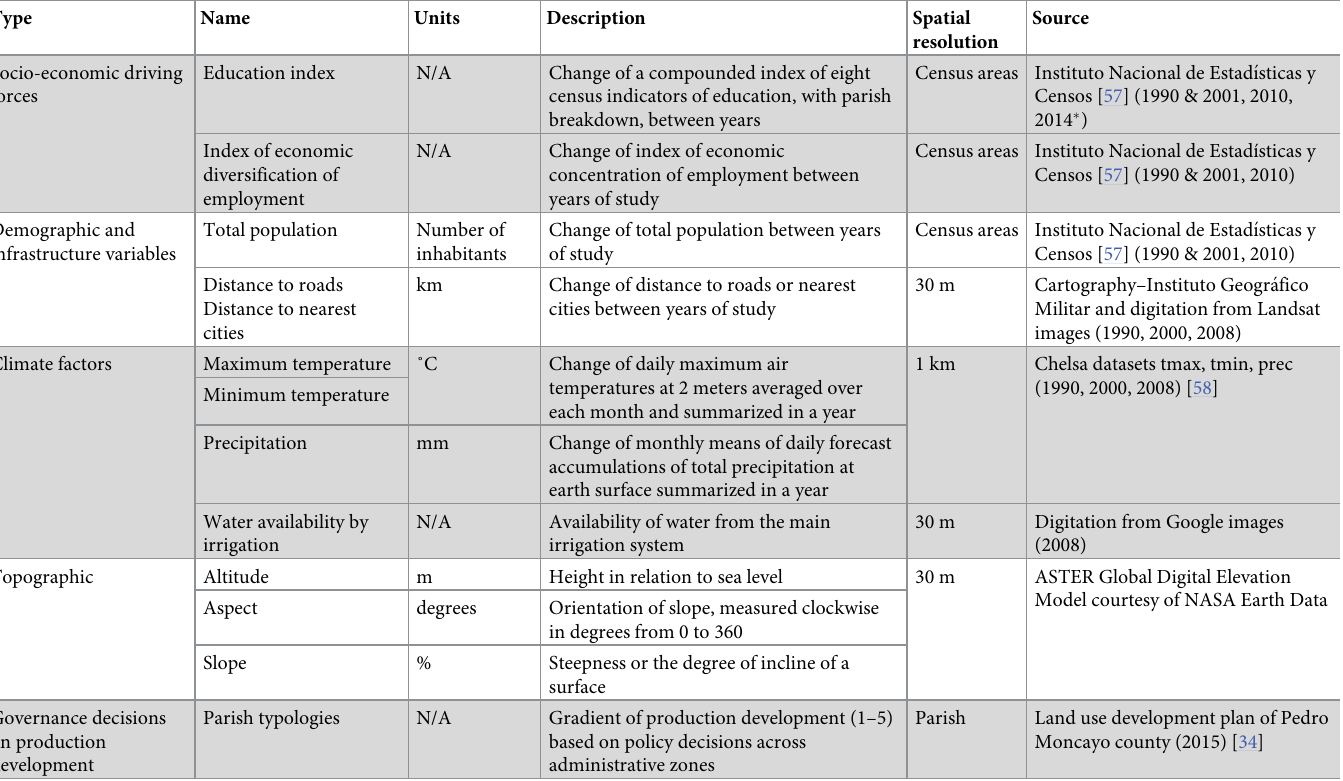
Table 1. Direct driving forces are included as predictors in the generalized additive model to explain probability of change of LULC